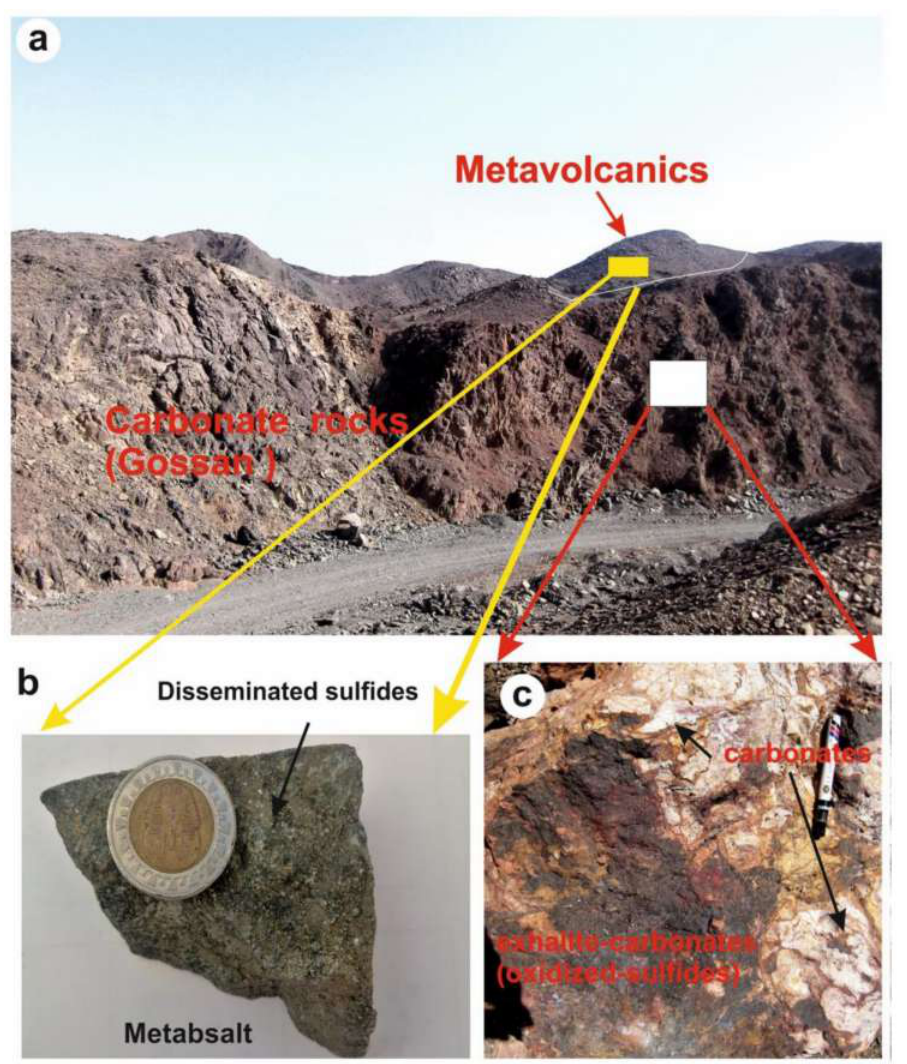
Figure 4. Field photographs showing ( a ) contact between carbonate rocks (gossans) and meta- volcanics, ( b ) a close-up view of sulfide disseminated in metabasaltic rock, and ( c ) a close-up view of reddish massive oxidized sulfides in carbonate